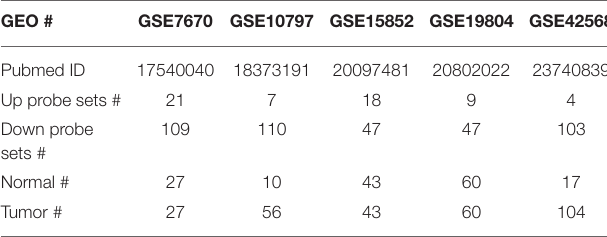
TABLE 1 | Summary of five datasets (normal vs. tumor samples) used for CMap analysis.